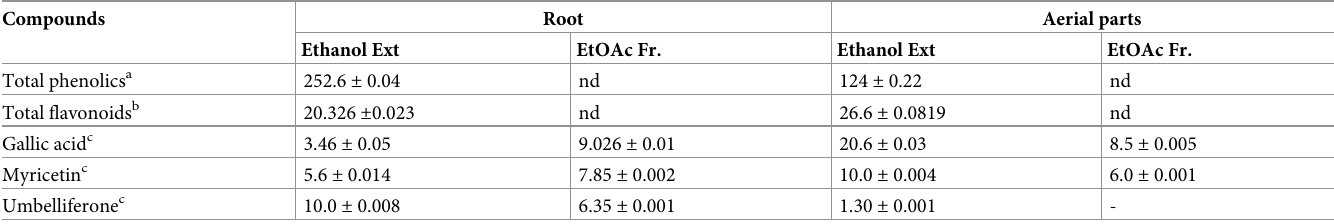
Table 4. Chemical characterization of REE and AEE and their ethyl acetate fractions. Compounds